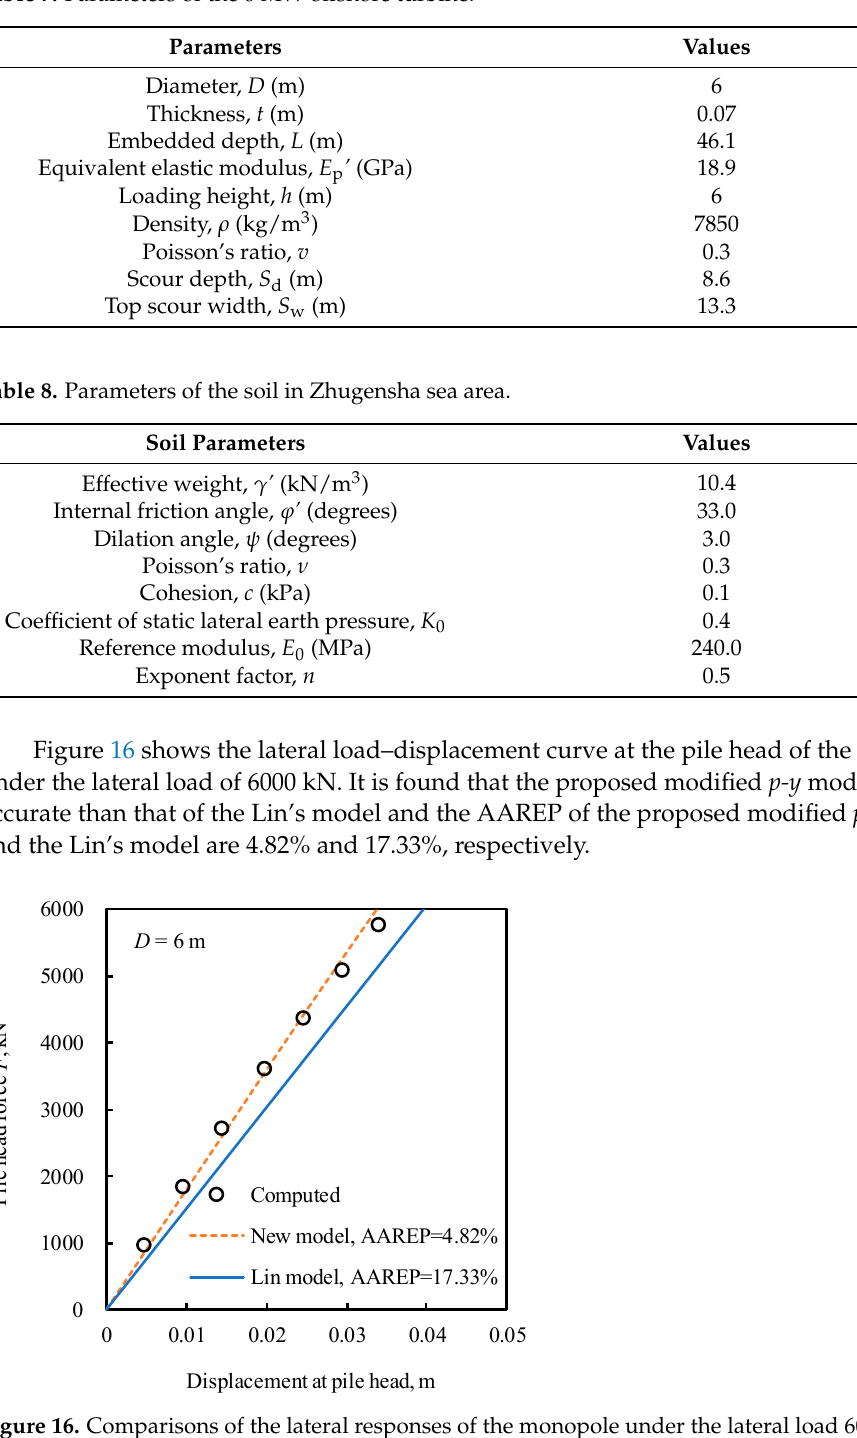
Table 7. Parameters of the 6 MW offshore turbine.